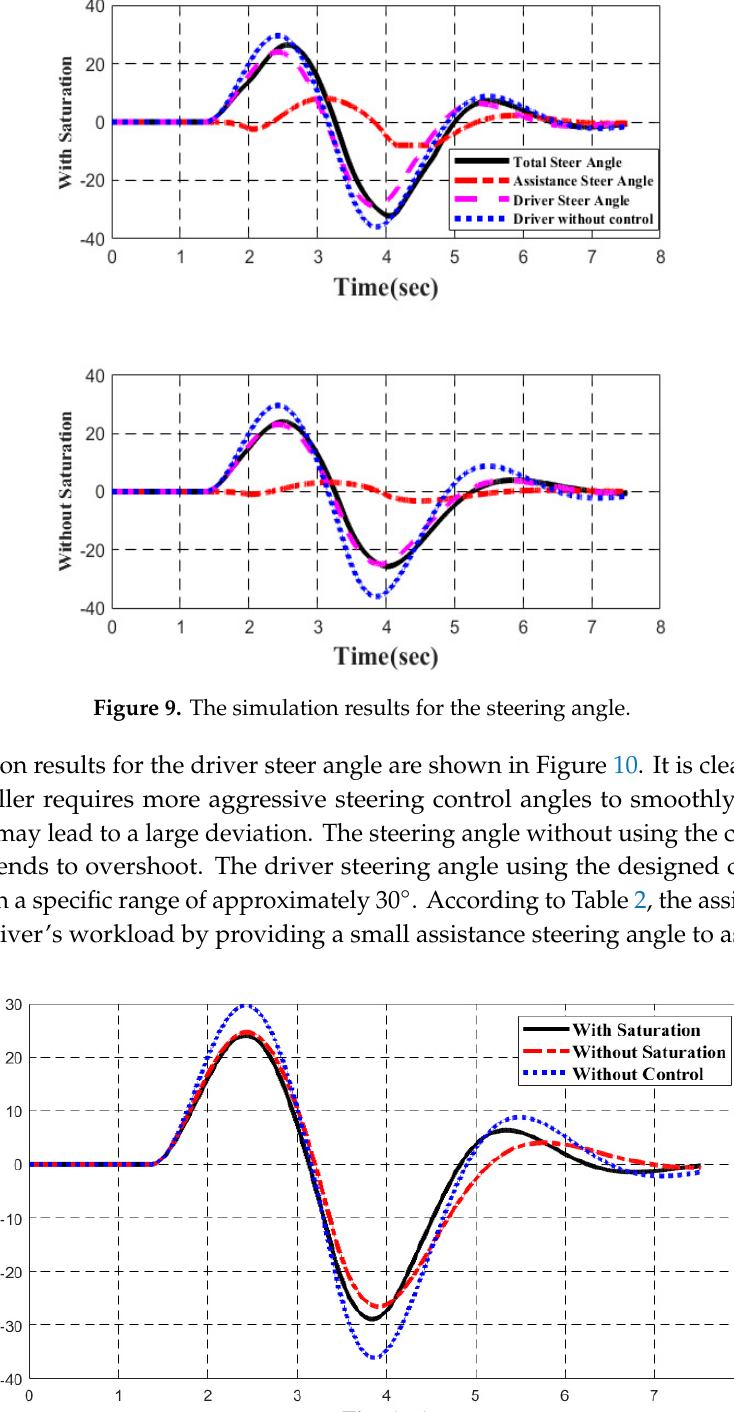
Figure 10. The simulation results for the driver steering angle. Table 2. Driver average